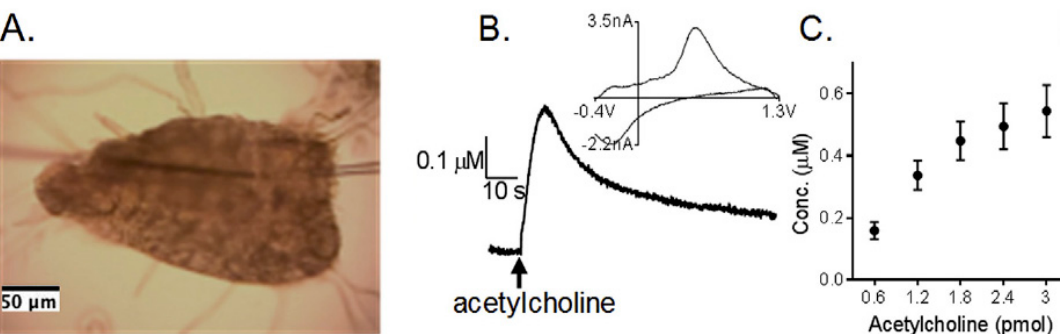
Figure 10. Acetylcholine-stimulated dopamine release in a Drosophila melanogaster ventral nerve cord (VNC). ( A ) Image showing electrode and stimulating pipet placed in VNC. ( B )Acetylcholine (1.8 pmol) stimulated dopamine release measured with fast-scan cyclic voltammetry (FSCV). ( C ) Evoked dopamine concentration as a function of the amount of acetylcholine [133]. Copyright 2018, Elsevier.